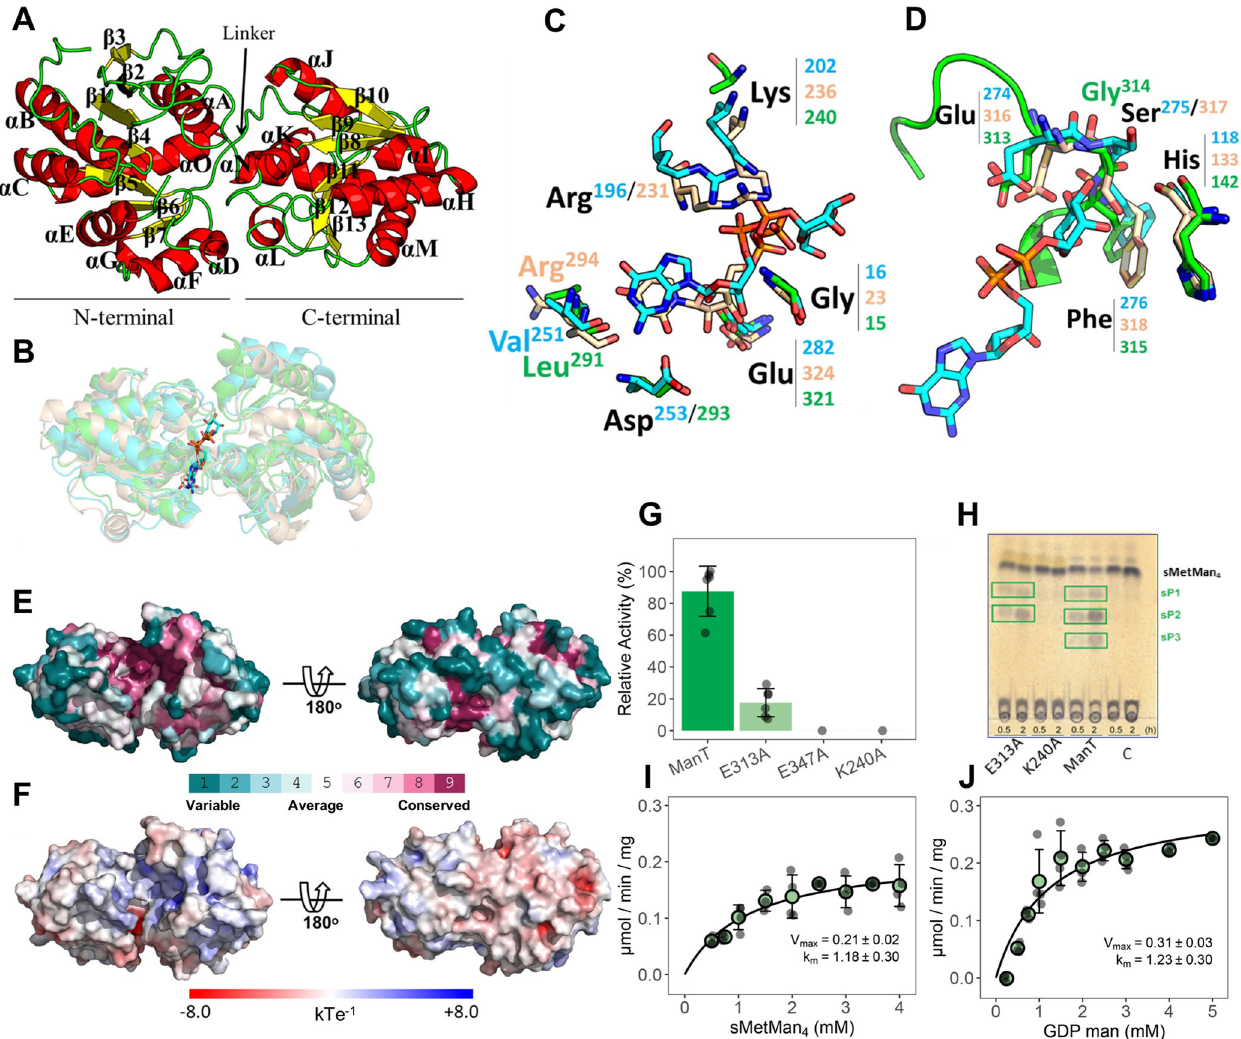
Fig. 5 Structural characterization of M. hassiacum ManT. A Cartoon representation of the crystallographic structure of ManT with secondary structure elements colored yellow ( β -strands β 1 – β 13) and red ( α -helices α A – α O). The N- and C-terminal domains of the protein and the inter-domain linker are also labeled. B Superposition of the three-dimensional structure of ManT with those of structural homologues. The crystal structure of ManT (green) was superposed with those of GT-4 family members PimA from M. smegmatis (cyan; PDB entry 2GEJ 33 ), and MshA from Corynebacterium glutamicum (tan; PDB entry 3C4Q 32 ). All proteins are represented as transparent cartoons and bound GDP-Man and UDP are represented as stick models with carbon atoms colored as the corresponding cartoon, nitrogen atoms blue and oxygen red. C , D Close-up views of the sugar-donor binding sites of PimA, MshA and ManT. Residues directly involved in the recognition of the nucleotide ( C ) and of the mannosyl moiety of GDP-Man ( D ) are shown as stick models and colored as in ( B ). The β 11- α K loop of ManT, in the conformation observed in molecule B is also represented. E Solid surface representation of ManT colored according to ConSurf 83 residue conservation score, calculated from the amino acid sequence alignment of 149 ManT homologues ( fi g. S10). The color-code gradient (from teal for variable positions to purple for highly conserved ones) is shown at the bottom of the panel. The left pose is oriented as in B (top view). The right pose results from a 180° rotation of the left pose around x (bottom view). F Solid surface representation of ManT colored according to its electrostatic surface potential (calculated with APBS 84 , as implemented in PyMOL (Schrödinger)), contoured from − 8 (red) to 8 kT/e (blue). The two views of the ManT monomer are those depicted in panel ( E ). G Relative activity of ManT variants Glu313Ala (E313A), Glu321Ala (E321A) and Lys240Ala (K240A) using sMetMan 4 and GDP-Man as substrates. H TLC analysis of the activity of ManT variants (30 min and 2 h) using sMetMan 4 as substrate; C, control reaction without enzyme. ManT products sP1 to sP3 are in green boxes. I , J Michaelis – Menten curve for ManT Glu313Ala variant as a function of substrates sMetMan 4 and GDP-Man, respectively. Kinetic parameters were examined at 37 °C. Error bars represent standard deviation of three